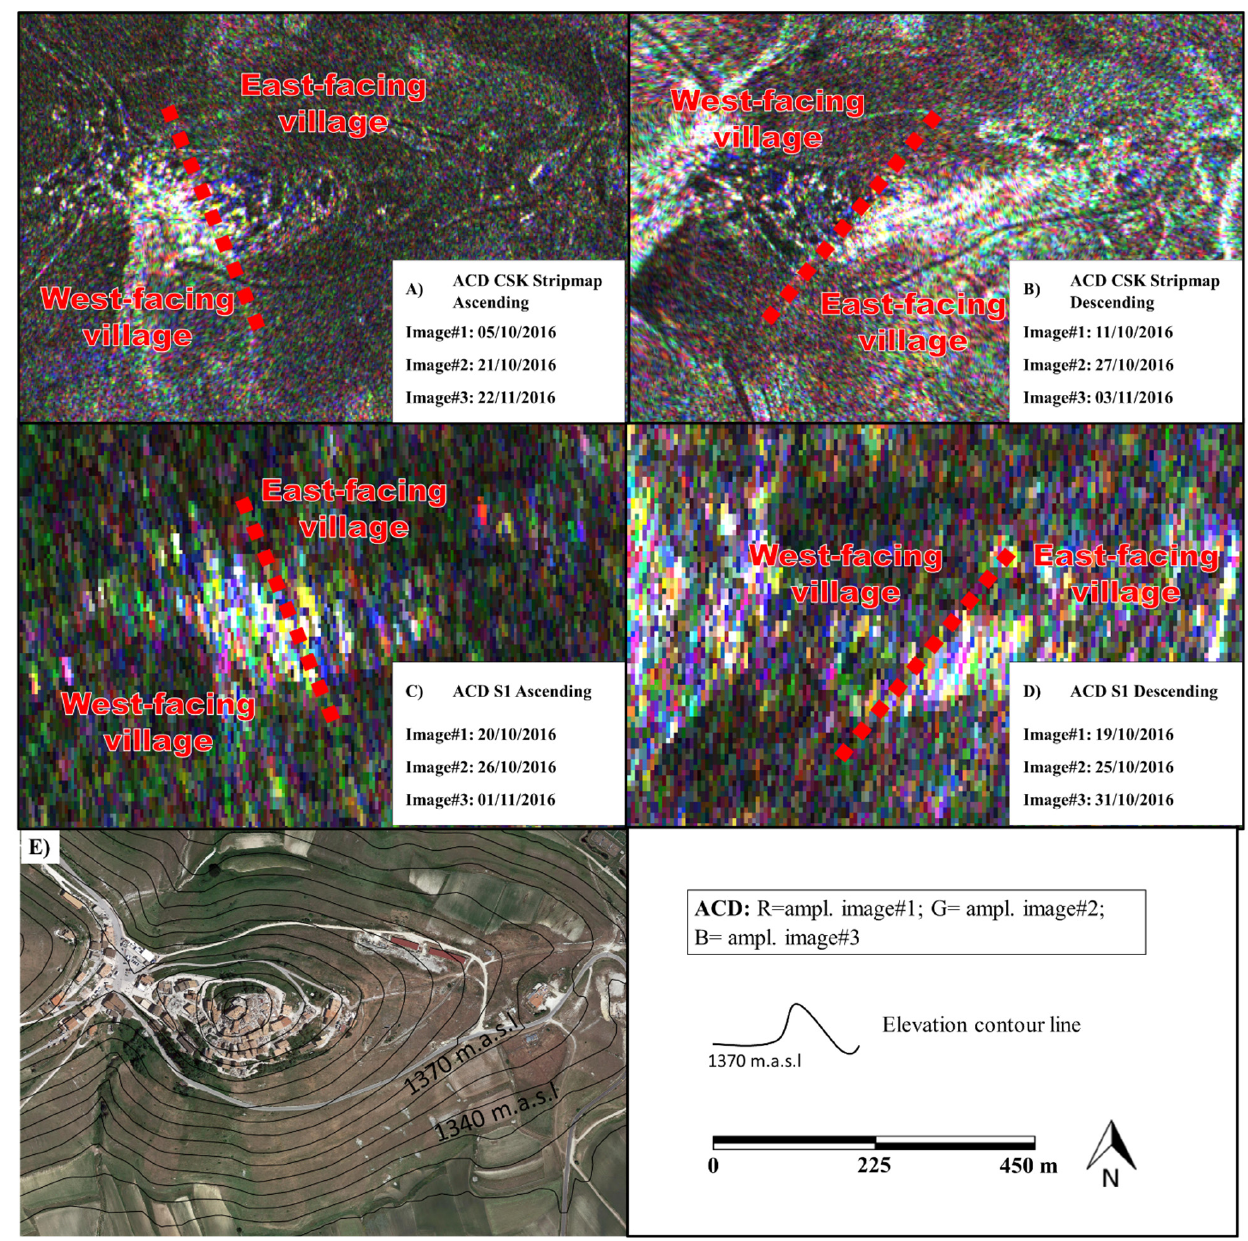
Figure 4. ACD results achieved in Castelluccio village: A) StripMap COSMO-SkyMed ascending; B) StripMap COSMO-SkyMed descending; C) IW Sentinel-1 ascending; D) IW Sentinel-1 descending; and E) Google Earth background of Castelluccio village and elevation contour lines (in m. a. s. l.). The red dotted lines indicatively separate the east-facing portion and the west-facing portion of the village. The difference of the foreshortening related to ascending and descending geometry is clear and demonstrates the importance of the double geometry to map damaged areas in complex topographic environments.